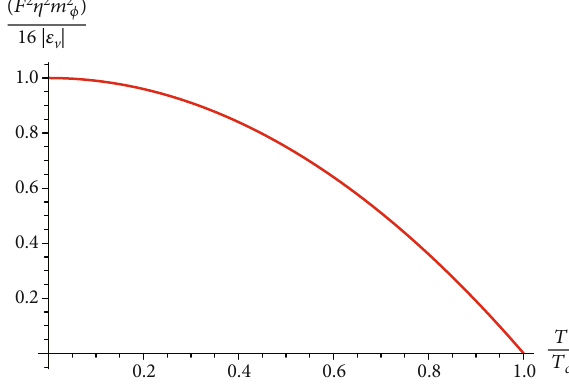
η 2 Þ F μν F / ð 16 ∣ ε ∣ Þ μν i ϕ v